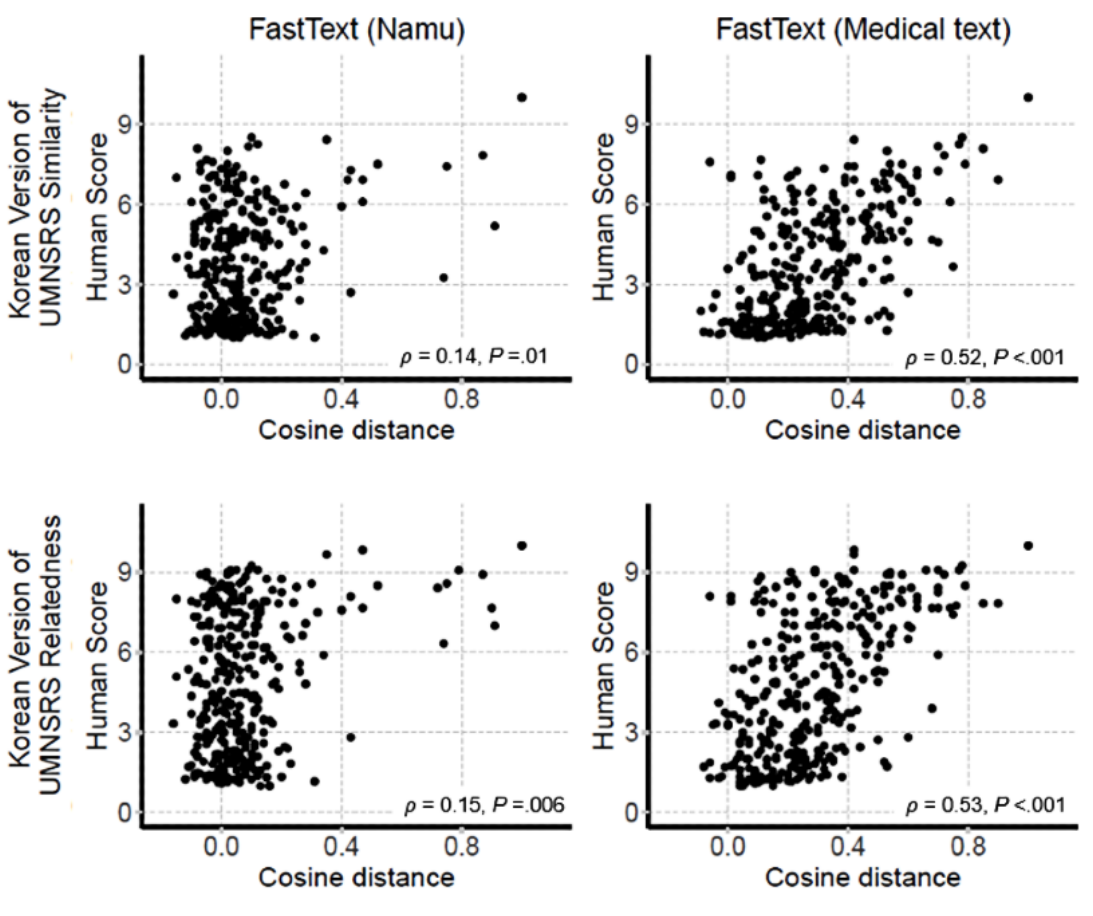
Figure 5. Correlation between the cosine distance of FastText embedding models and the human evaluations by 12 health information managers of the Korean version of the University of Minnesota Semantic Relatedness Set (UMNSRS) word pair